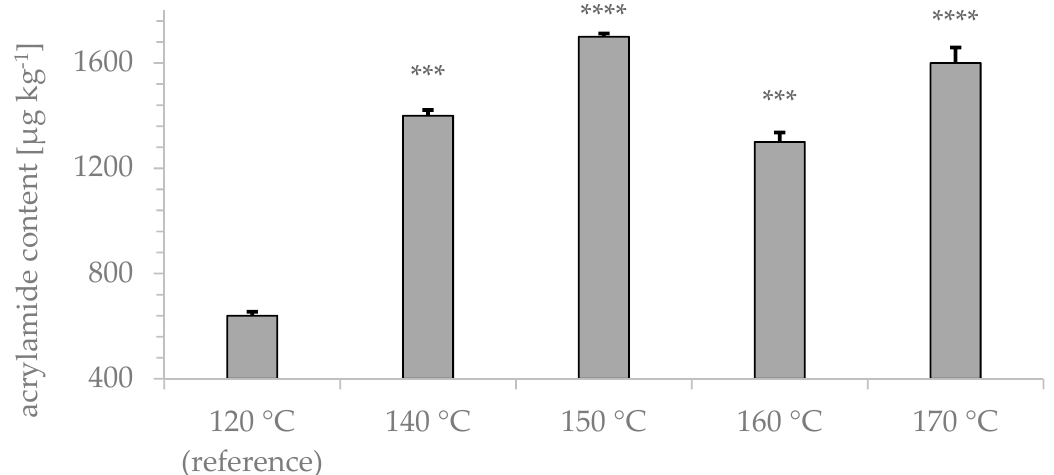
Figure 4. Influence of roasting temperature on acrylamide formation. Samples ( n = 5) roasted at 120 ◦ C, 140 ◦ C, 150 ◦ C, 160 ◦ C, and 170 ◦ C for 45 min were analyzed by GC-MS after xanthydrol derivatization. **** p < 0.0001, *** p < 0.001, ** p < 0.01 and * p < 0.05 indicate significant di ff erences from the reference.